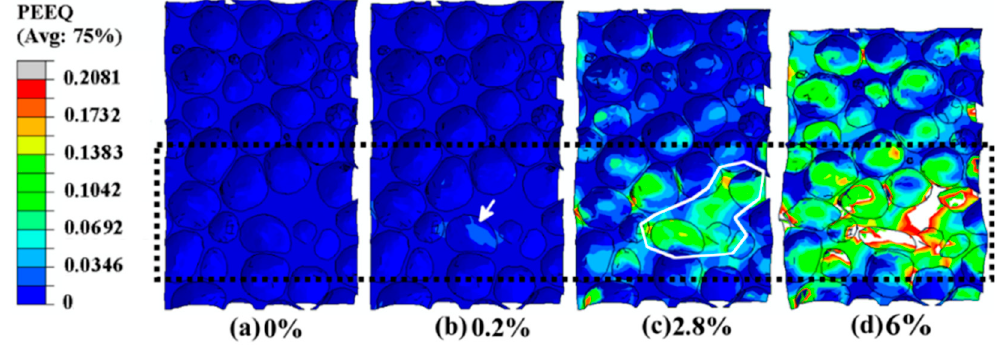
Figure 3. Computed strain distribution in a specimen at different strain deformation levels. PEEQ (indicates the equivalent plastic strain in ABAQUS): initiation and evolution of the equivalent plastic strain. ( a ) the strain distribution of the specimen before loading, showing no strain concentration; ( b ) the strain distribution of the specimen at its overall strain of 0.2%, showing the initiation of the plastic strain; ( c ) the strain distribution of the specimen at its overall strain of 2.8%, showing the propagation of the plastic strain band; ( d ) the strain distribution of the specimen at its overall strain of 6%, showing the formation of the collapse band in the specimen.